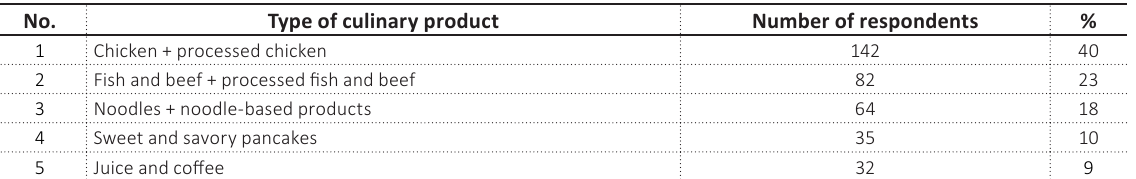
Table 2. Distribution of